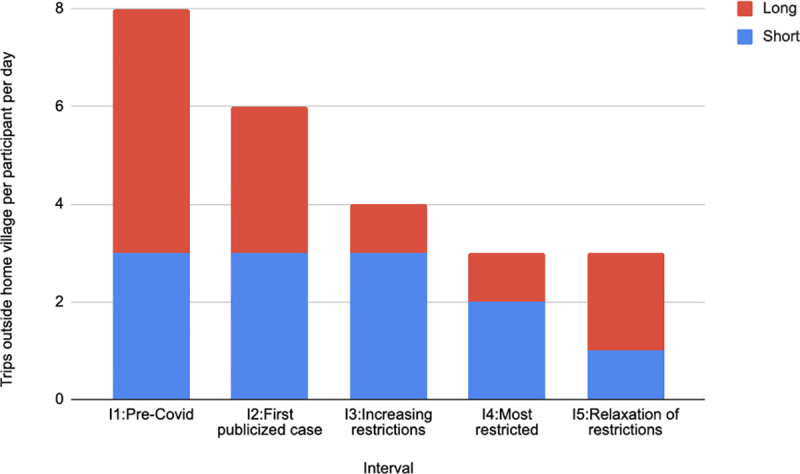
Number of trips outside the home village per participant per day in each interval, broken down into long and short trips.Short trips are defined as those for which the maximum distance from the village boundary is less than 500 meters and long trips are those greater than 500 meters.